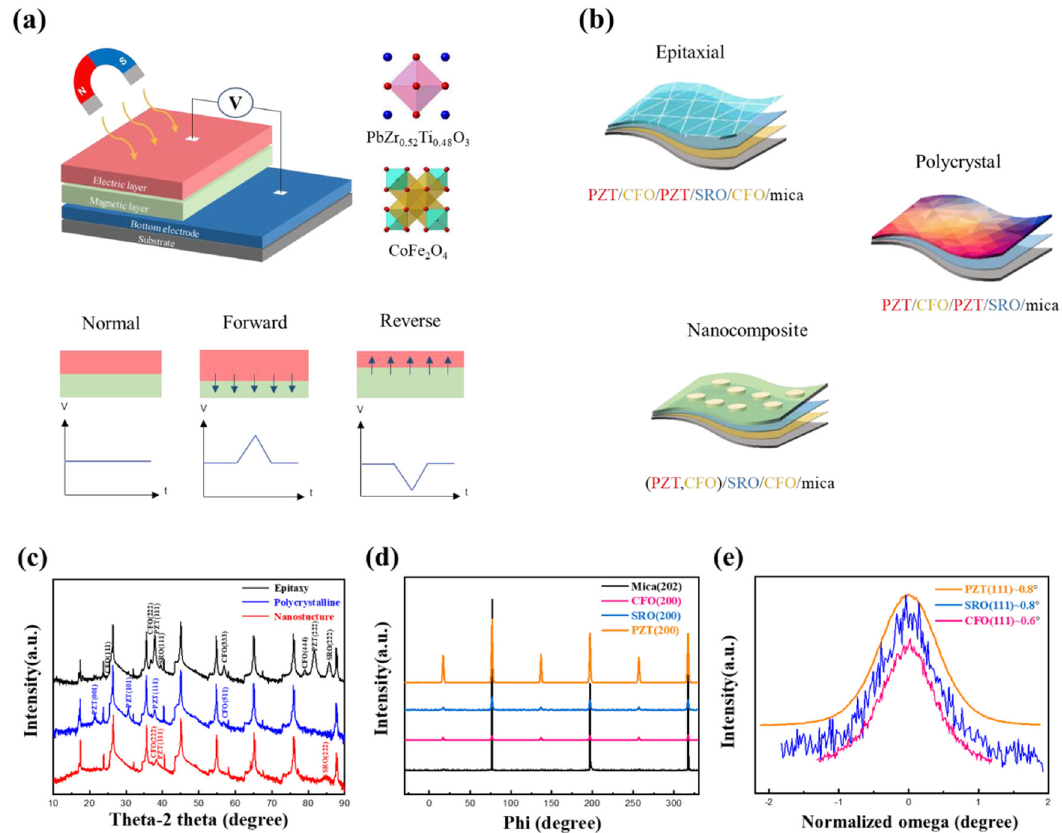
Fig. 1 Structure and device design. a Schematic interaction between magnetostriction and piezoelectric parts and the design of proximity sensing device. b Crystal structure of 2-2 (layer-by-layer PZT/CFO/PZT) and 1-3 (PZT, CFO) nanostructure with two different growth mechanisms. c Out-of-plane XRD 2 θ - θ scan of the heterostructures. d Phi scans of muscovite {202}, CFO {200}, SRO {200} and PZT {200}. e Rocking curves of PZT (222), SRO (111), and CFO